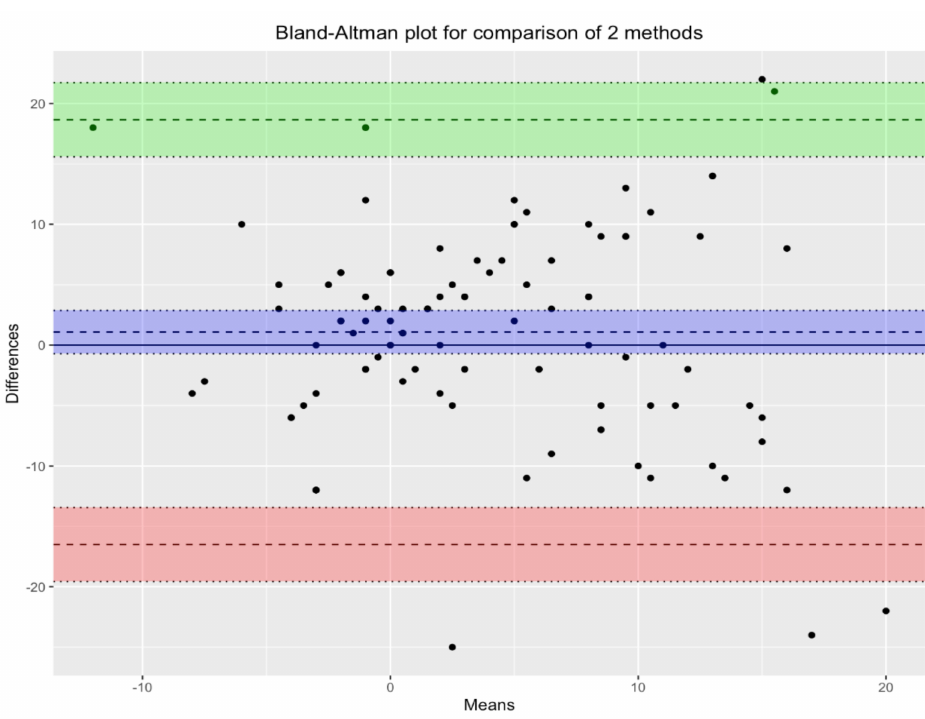
Figure 3. Bland-Altman plot for comparison of the two methods. There is agreement between the two devices. Violet lines define the biases of measurements. Green and pink lines define the the corresponding 95% confidence intervals.